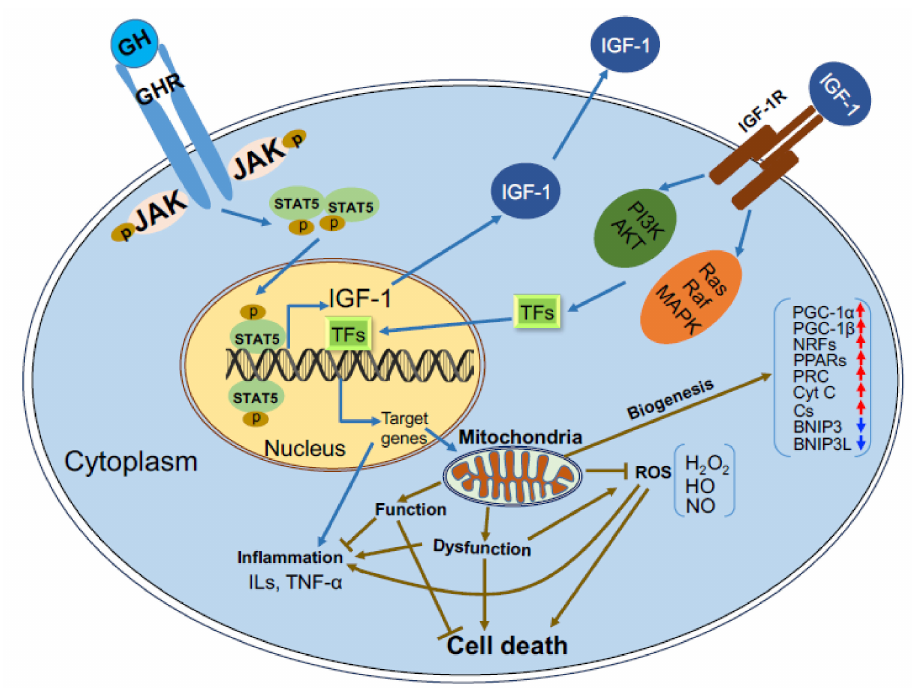
Figure 2. Schematic summary of the major e ff ects of GH / IGF-1 on mitochondrial gene expression: Upon binding of GH to the GHR, the Janus kinase (JAK)-Signal transducer and activator of transcription 5 (STAT5) signaling pathway is activated, leading mostly to increases in IGF-1 transcription. Binding of IGF-1 to the tyrosine kinase IGF-1R stimulates several signaling pathways including the Phosphoinositide-3-kinase (PI3K) / Protein kinase B (PKB or AKT) and Ras / Raf / Mitogen-activated protein kinase (MAPK), involving phosphorylation and dephosphorylation of candidate